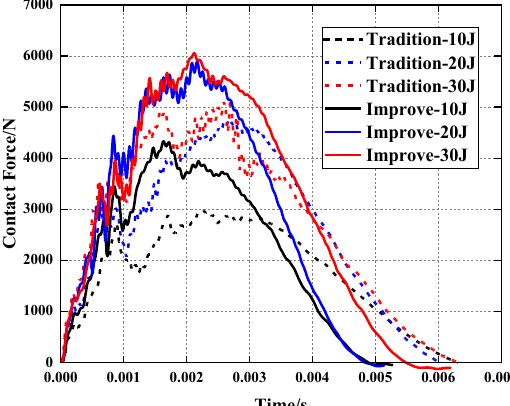
Figure 9. Comparison of contact force history of re-entrant honeycomb sandwich panels before and after improvement. Table 5. Comparison of face sheet deformation depth of two structures under different impact energies.